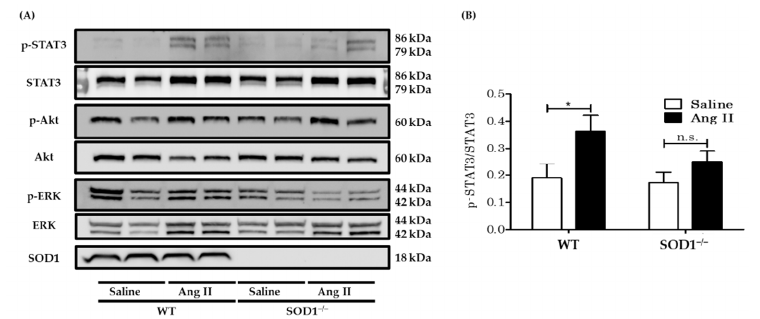
Figure 4. The protein expressions of aortas from WT and SOD1 − / − mice with saline or AngII . ( A ) Representative results of Western blot analyses of phosphorylated STAT3, phosphorylated Akt, phosphorylated ERK1/2, and SOD1 in aortas from WT and SOD1 − / − mice, with saline or AngII. ( B ) Quantitative analyses by densitometry of immunoblots expressed as ratios of phosphorylated STAT3 to STAT3. ( n = 8 per group. * p < 0.05 n.s.: not significant) Error bars represent SEM. STAT3: signal transducer and activator of transcription 3; ERK: extracellular signal-regulated kinase.